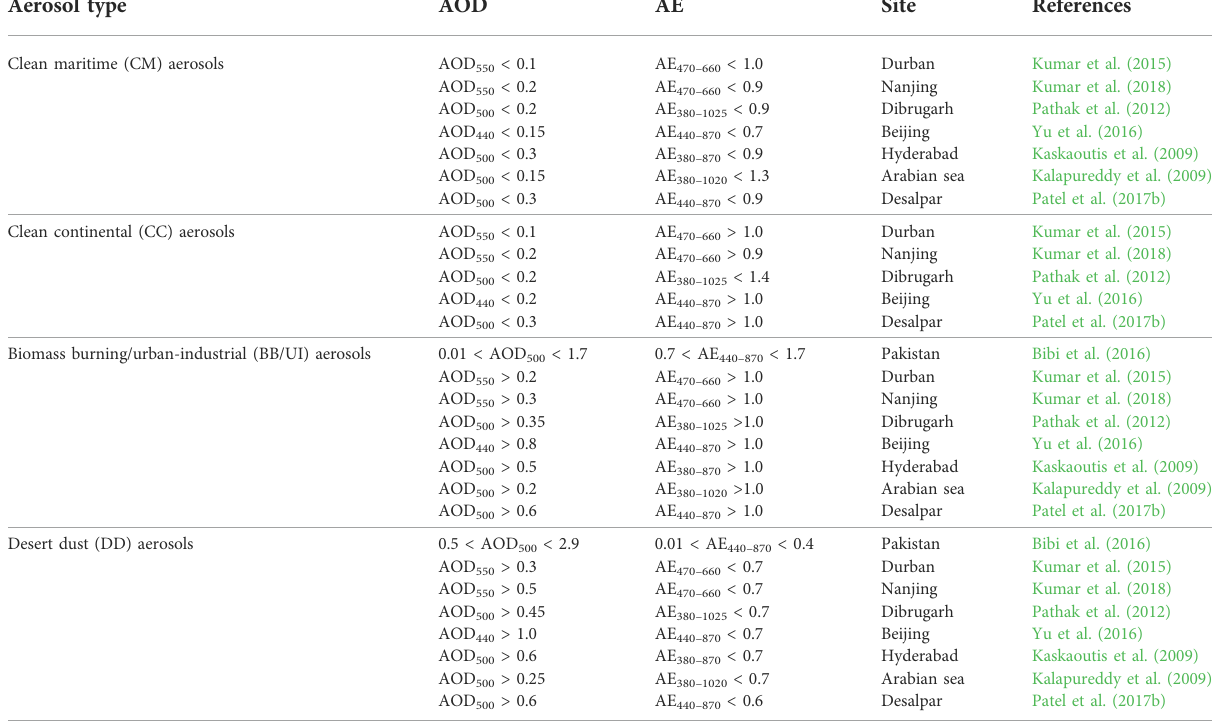
TABLE 2 The ranges of AOD and AE for aerosol types used in GA